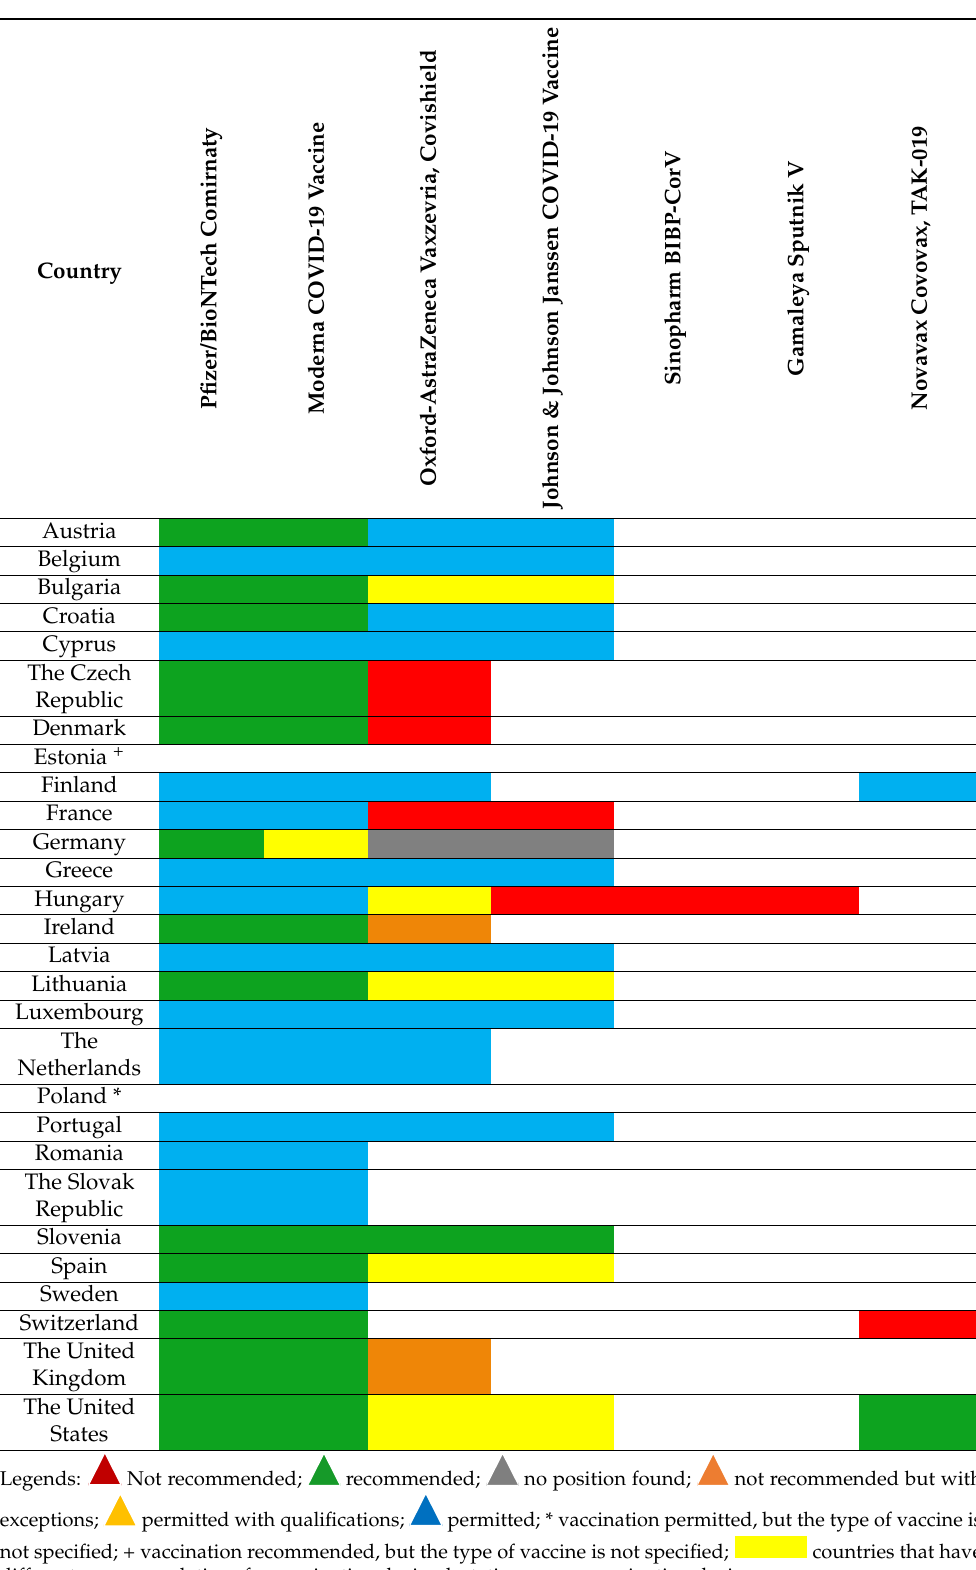
Country Country Country